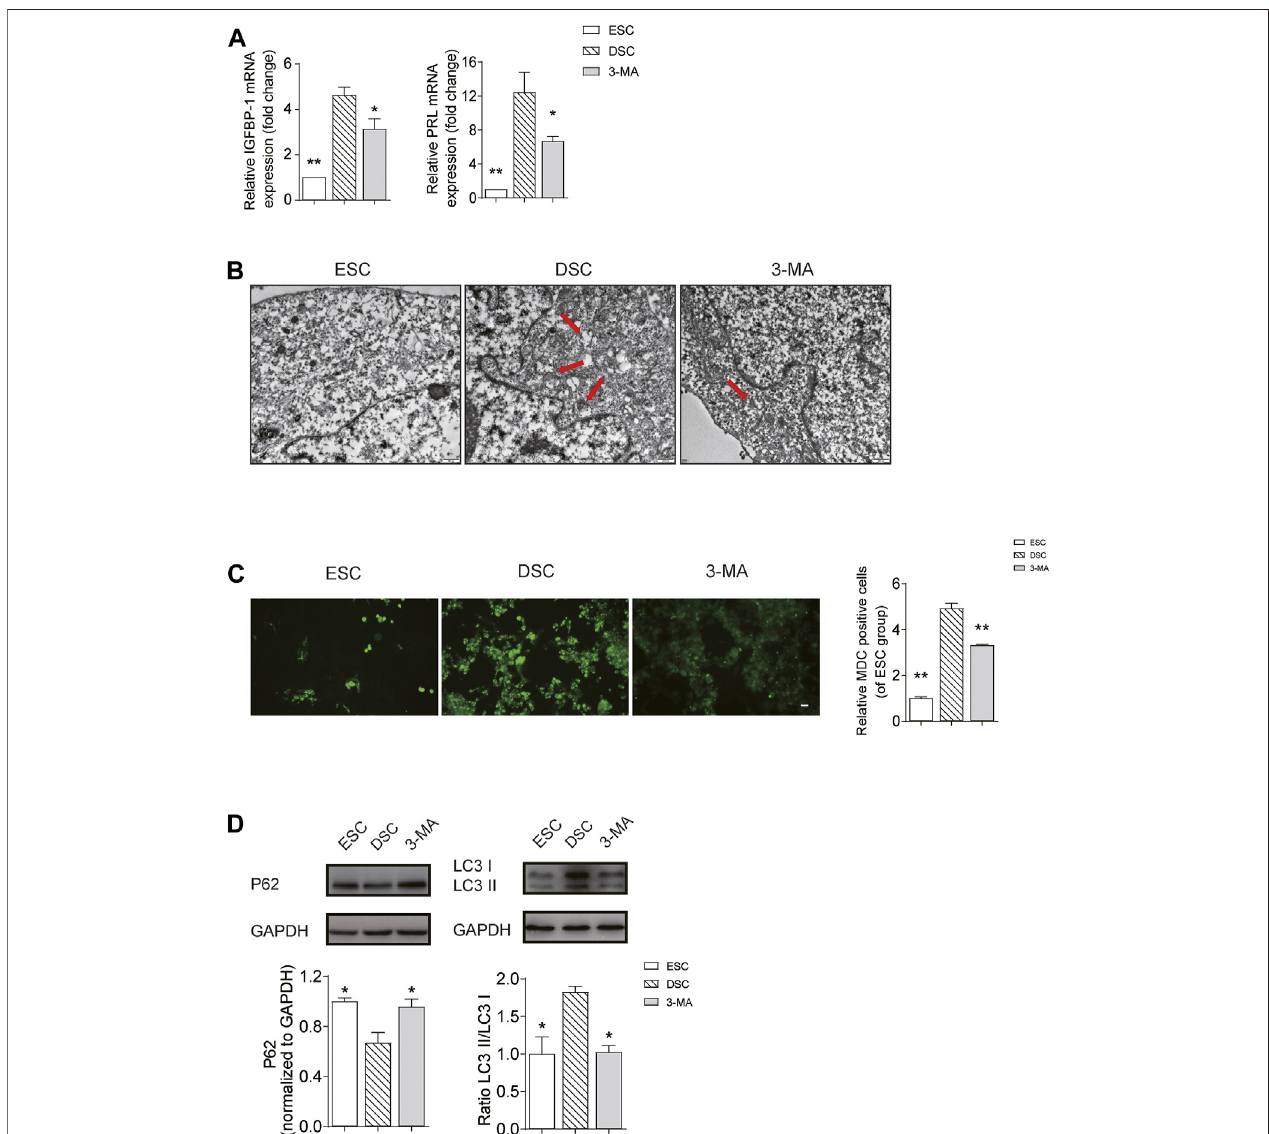
FIGURE5| Autophagywasincreasedindecidualization invitro ,whileinhibitionofautophagycanimpairdecidualization. (A) ThemRNAlevelsofIGFBP1andPRLin the ESC, DSC and 3-MA group; (B) Theautophagosomes in the ESC,DSC and 3-MAgroup observed byTEM (scale bar:500 nm); (C) The autophagy level in the ESC, DSC and 3-MA group observed by MDC assay (scale bar: 50 μ m); (D) The expression levels of LC3II/LC3I and p62 in the ESC, DSC and 3-MA group used by Western blot. * p < 0.05 vs. DSC group; ** p < 0.01 vs. DSC group.